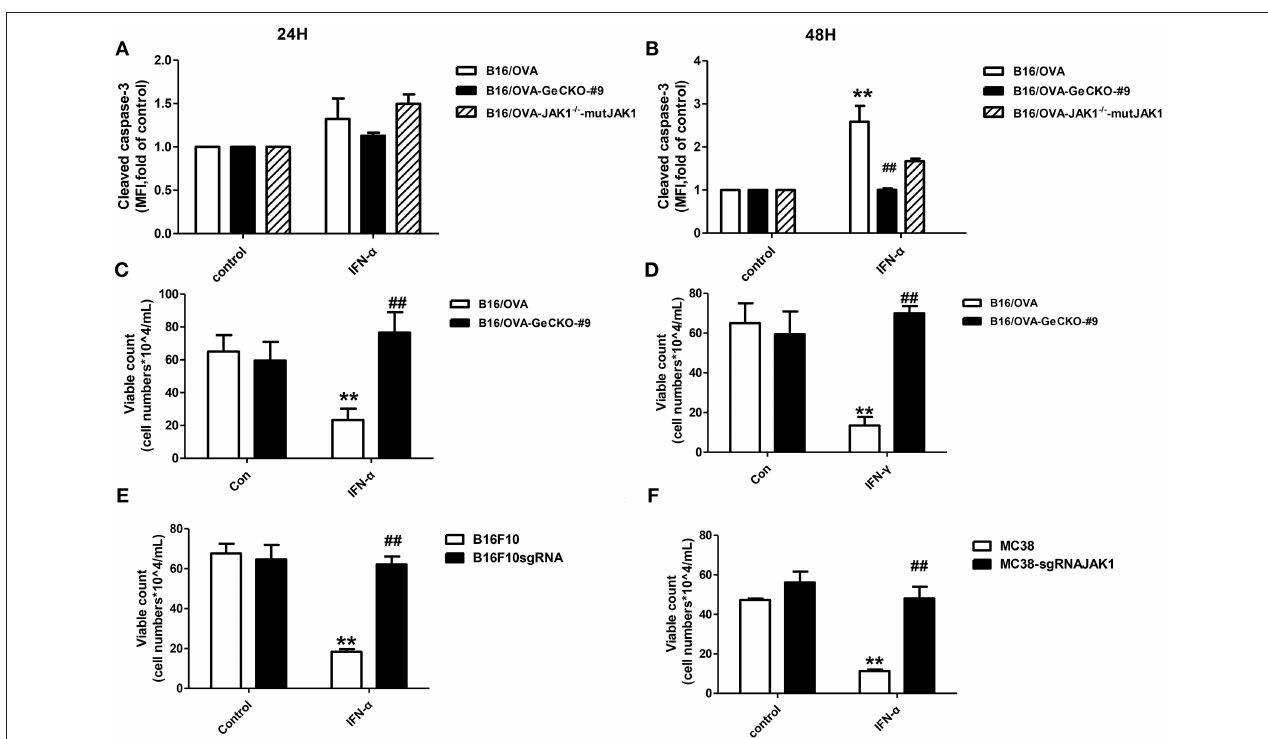
FIGURE 5 | Loss of JAK1 inhibits tumor cell apoptosis. B16/OVA cells and their derivatives were stimulated with mIFN- γ (100ng/mL) or mIFN- α 4 (500ng/mL) for 72h. (A,B) Cleaved caspase-3 expression was analyzed by flow cytometry 24h later. (C,D) Remaining live cells were counted with a hemocytometer after 72h. (E,F) B16F10 and MC38 with JAK1 were stimulated with mIFN- α 4 (500ng/mL) for 72h and the remaining live cells were counted. Data are presented as mean ± SEM. ** P < 0.01 vs. B16/OVA/B16F10/MC38 control group; ## P < 0.01 vs. B16/OVA/B16F10/MC38 + IFN- α group.